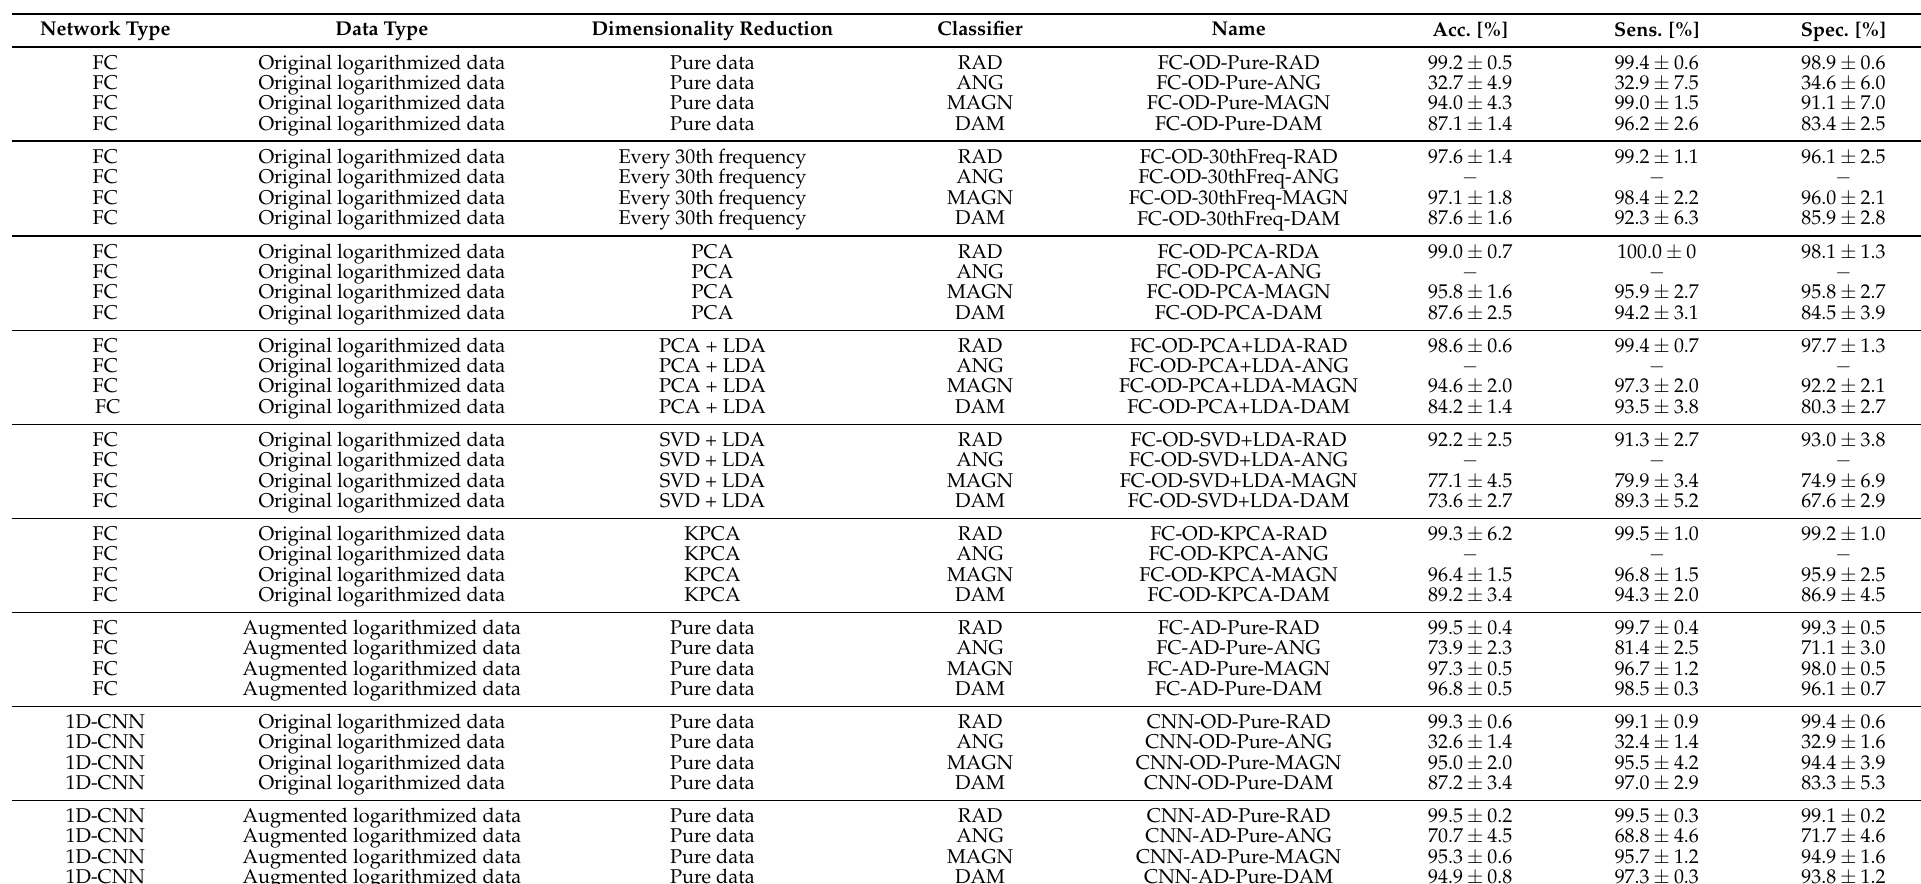
Table A1. All trained models and combinations of network, data type and dimensionality. Test accuracy, sensitivity, specificity and validation accuracy with cross-validation error is